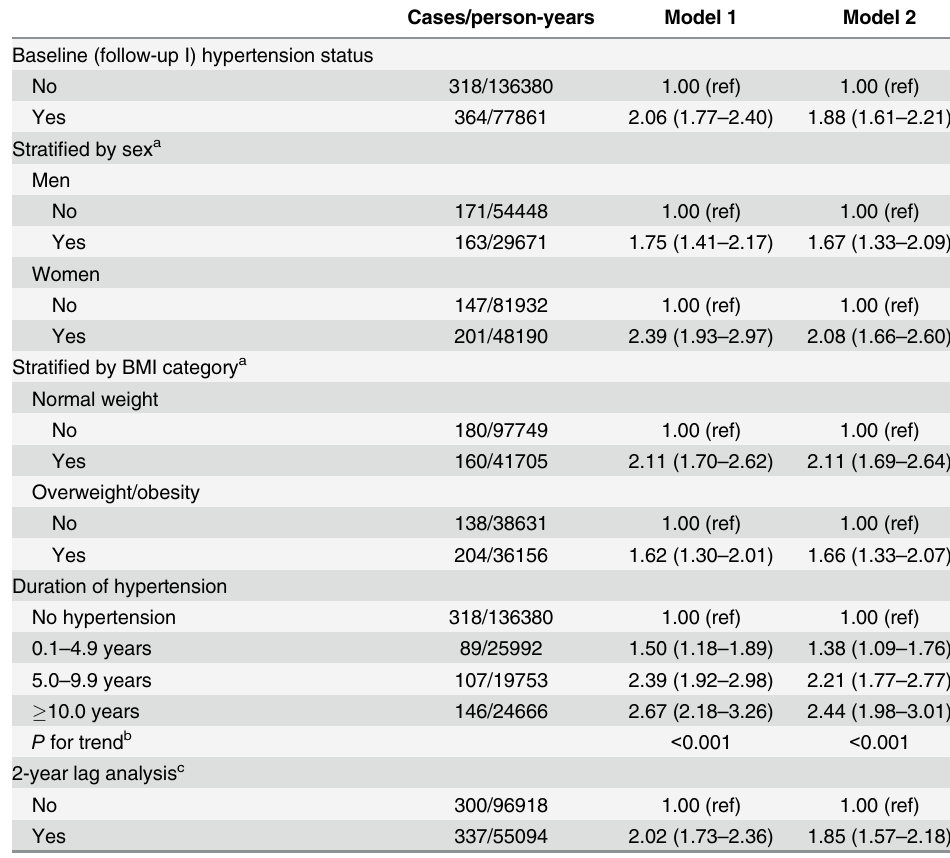
Table 2. Hazard ratios (95% confidence intervals) for risk of gout according to hypertension status: The Singapore Chinese Health Study (1999 –